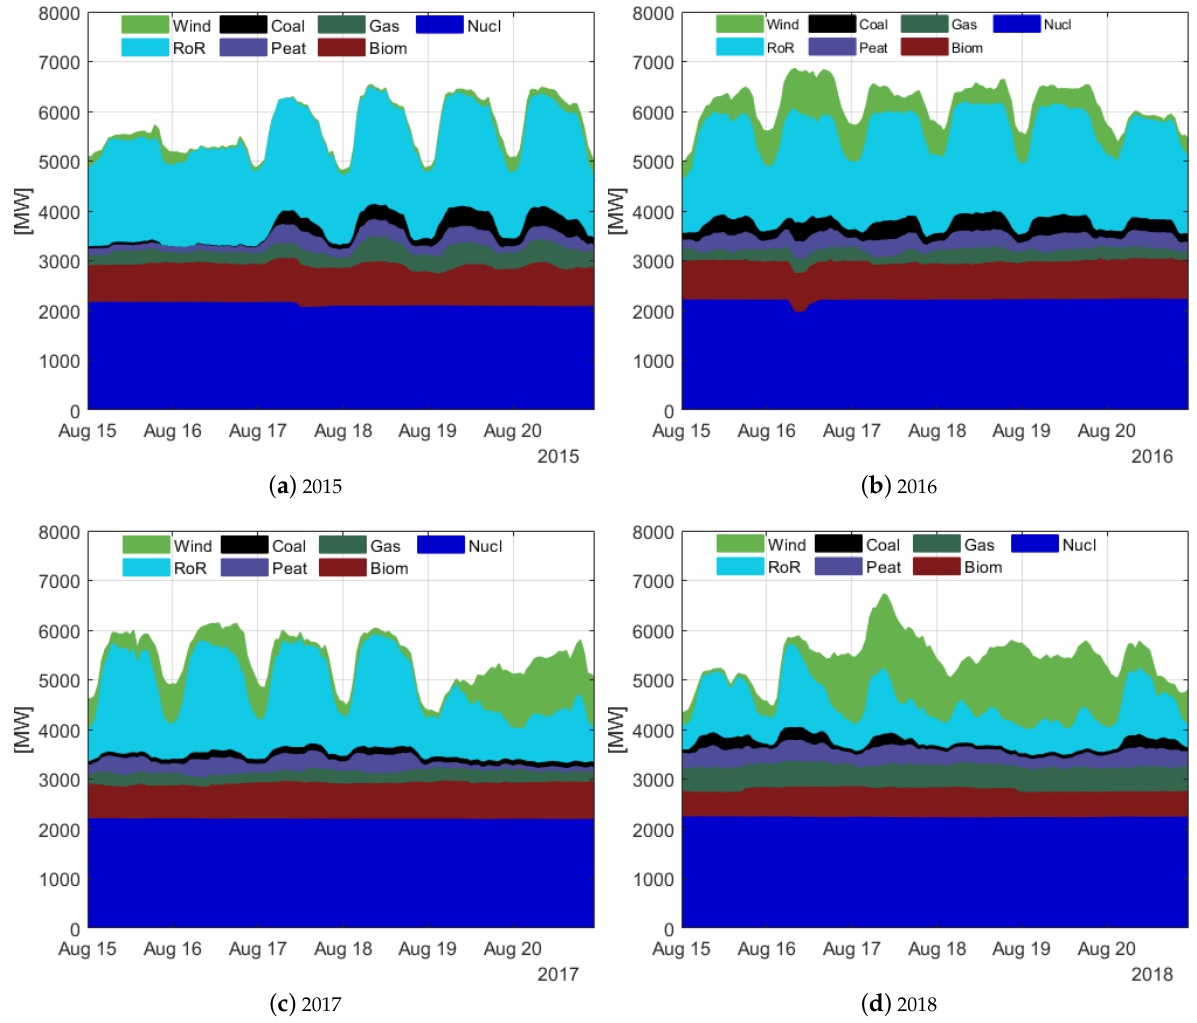
Figure 11. Comparison of the energy mix in Finland in